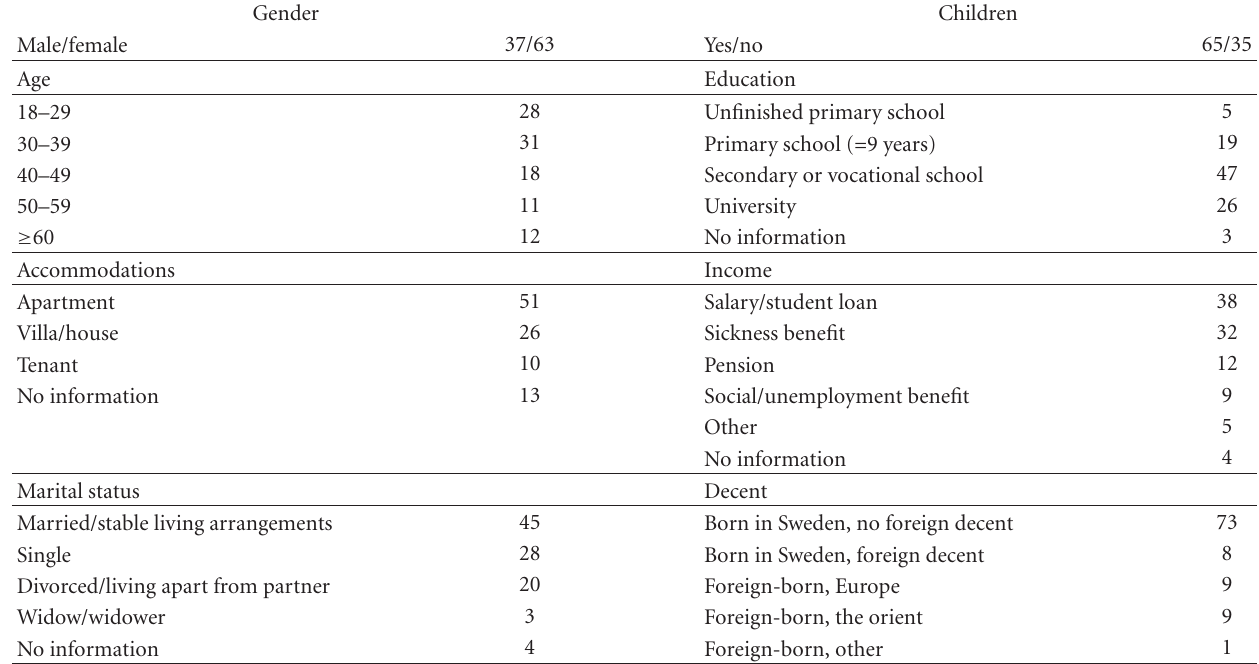
Table 2: Sociodemographic description of the included patients ( n = 94). All numbers are percentages.